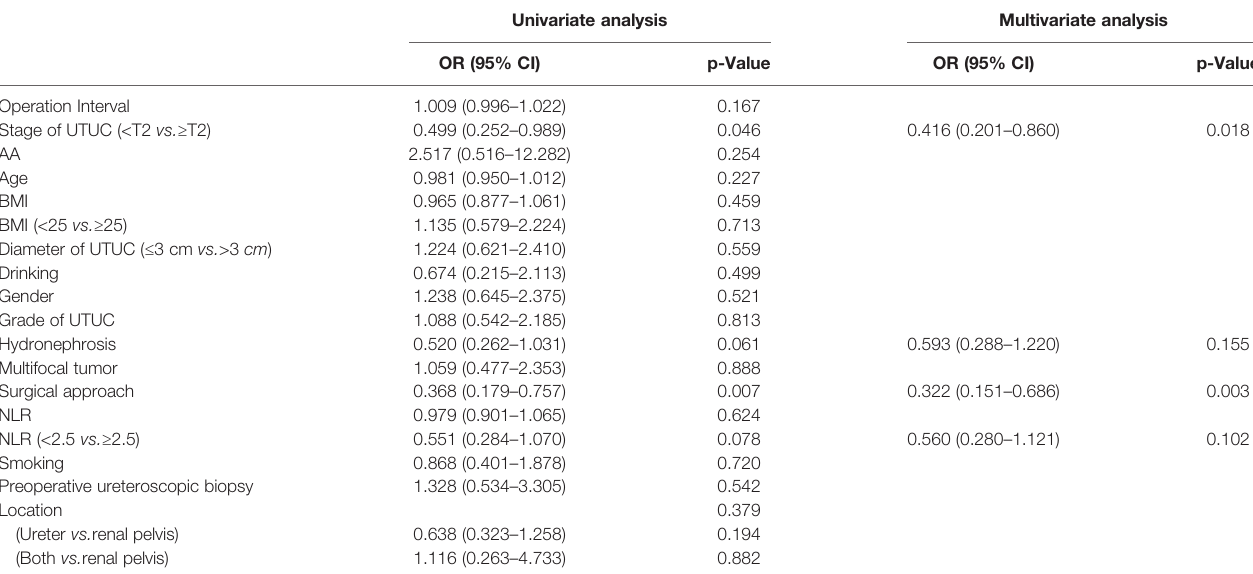
TABLE 4 | Univariate and multivariate analyses for factors associated with multifocal BC after